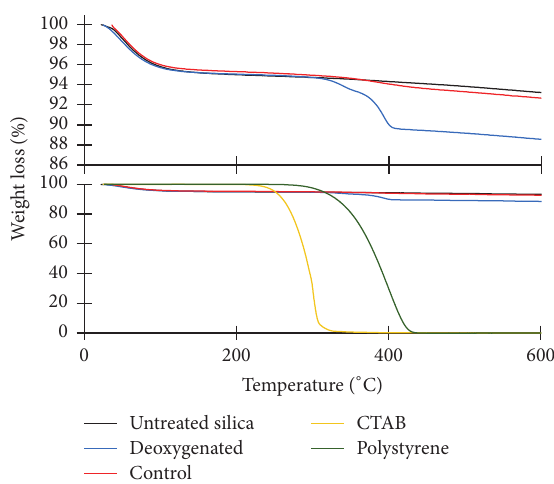
Figure 2: TGA profile for (black line) untreated silica, (blue line) deoxygenated admicellar polymerization on silica (M/I of 1000, 6 hours of polymerization), and (red line) control admicellar polymerization on silica (M/I of 1000, 6 hours of